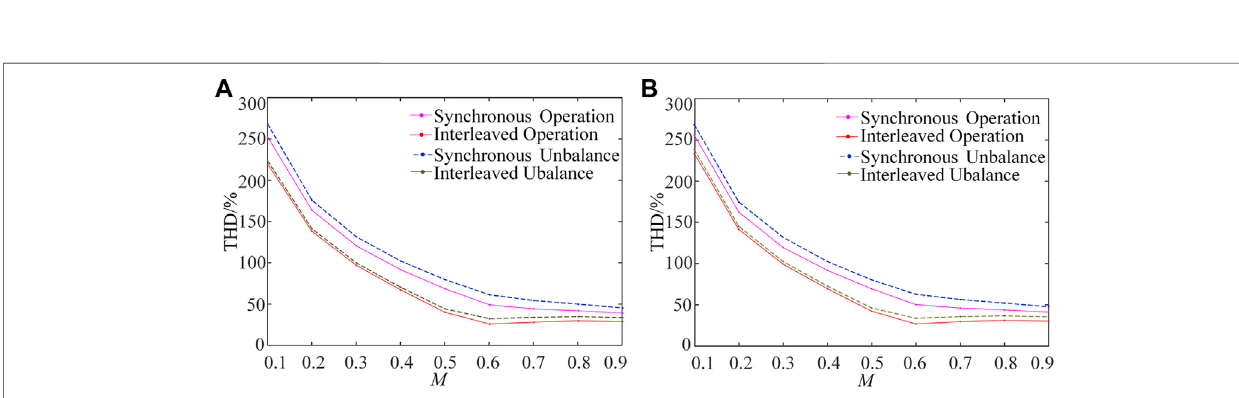
Frontiers in Energy Research |